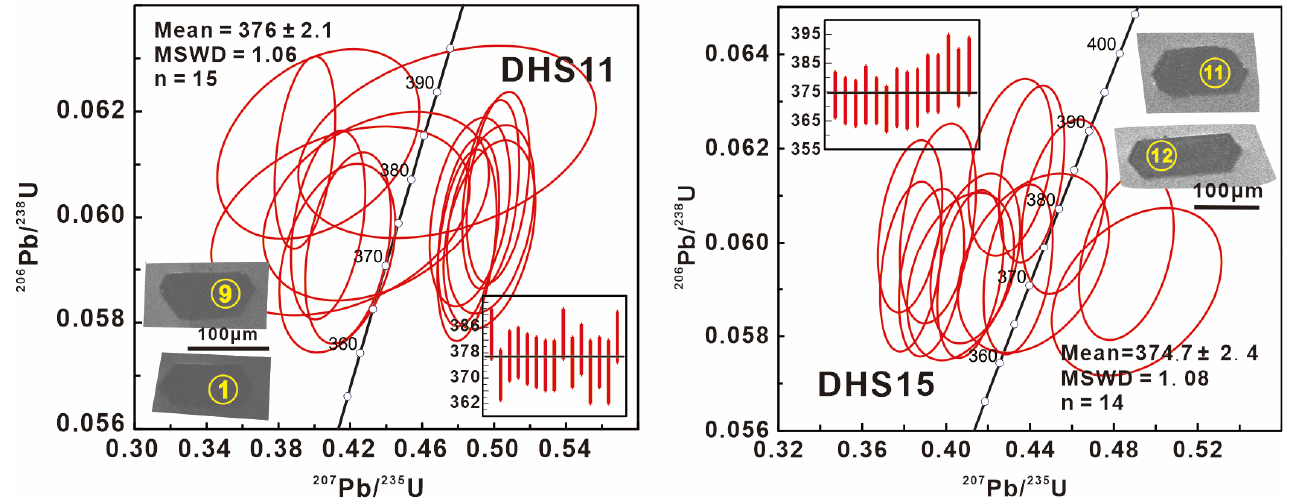
Figure 4. Concordia diagrams for samples DHS11 and DSH15 from the Duhongshan granites. Cathodoluminescence images for two zircons from each sample are also known.